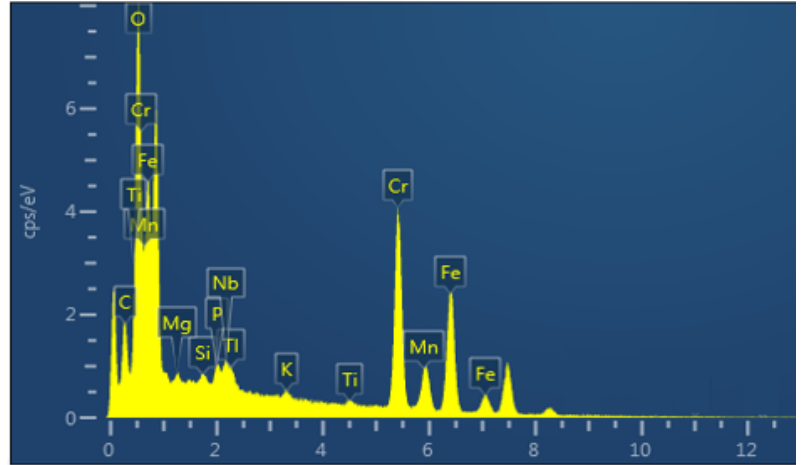
Figure 5. Fracture morphology of SFC of nickel-based alloy: ( a ) all-sided fracture surface; ( b ) selected zoom of ( a ); ( c ) liquefaction case 1; and ( d ) liquefaction case 2.